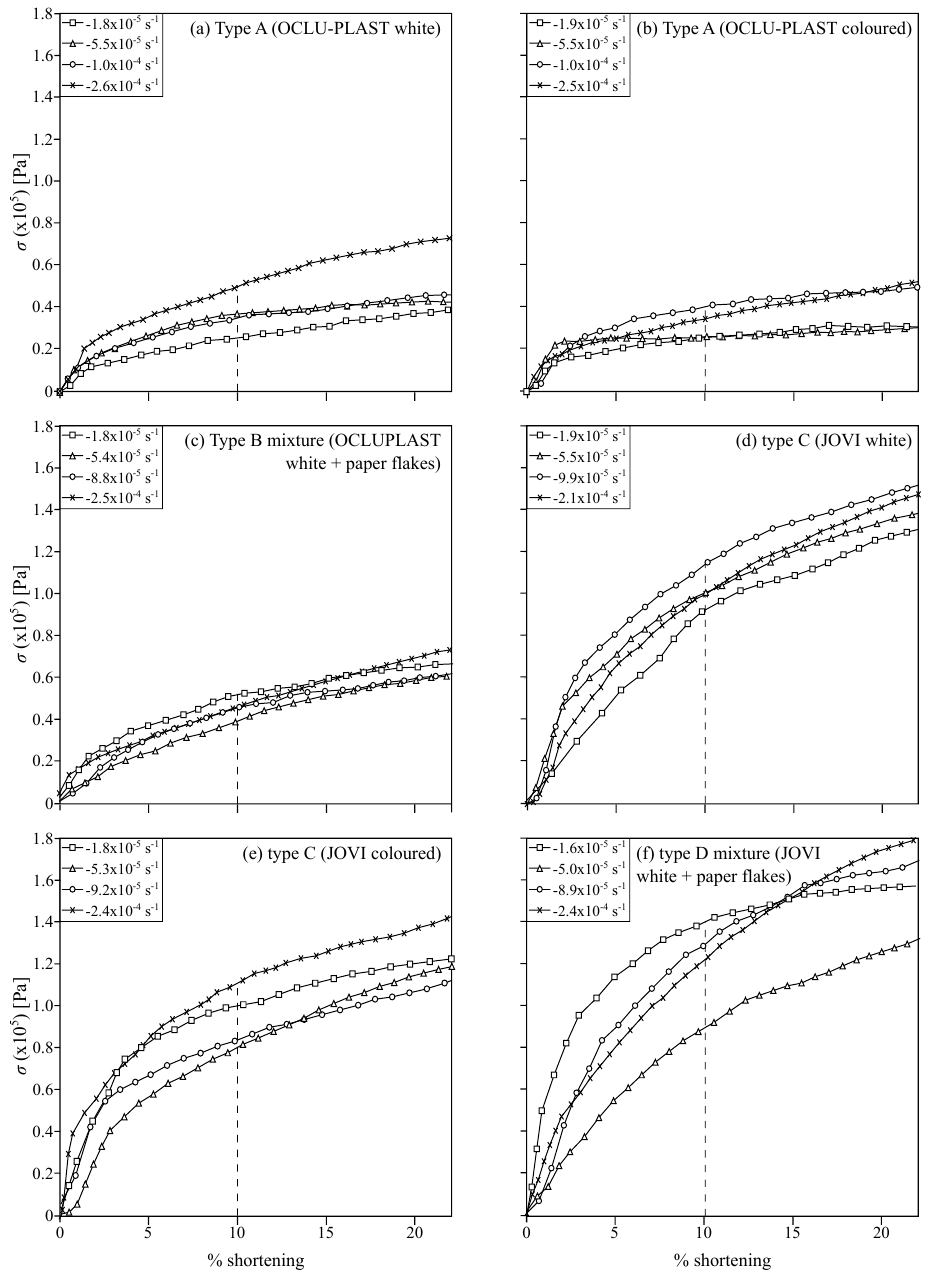
Figure 3. Stress vs. axial strain (expressed in % shortening) curves for the materials used in this study at different strain rates. Dashed lines indicate the strain reference value used for comparison of material properties (10%